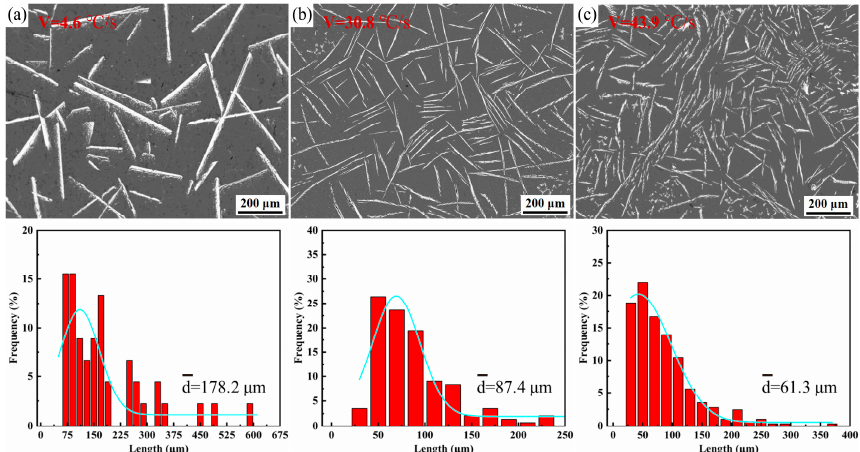
Figure 7. SEM (backscatter electron mode) images and distribution of Al 3 Zr particle lengths in the remelted Al-5Zr alloy at different cooling rate conditions with 1320 ◦ C remelting temperature (the blue line is the fit curve): ( a ) low velocity; ( b ) intermediate velocity; ( c ) high